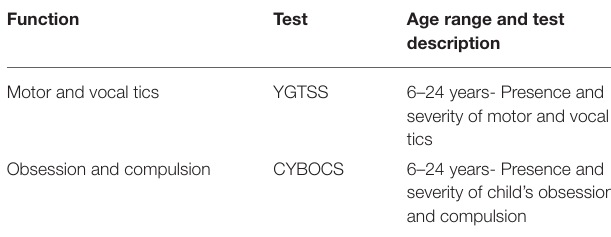
TABLE 1 | Neuropsychological